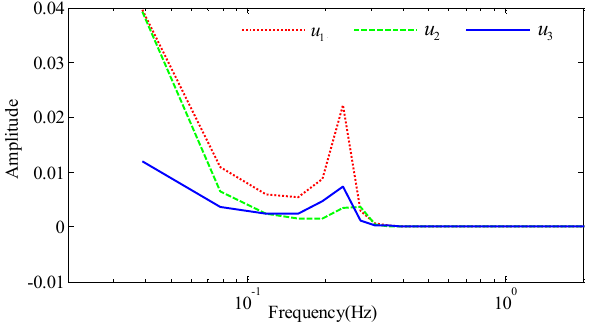
Figure 4. The power spectral density of the direction cosines .